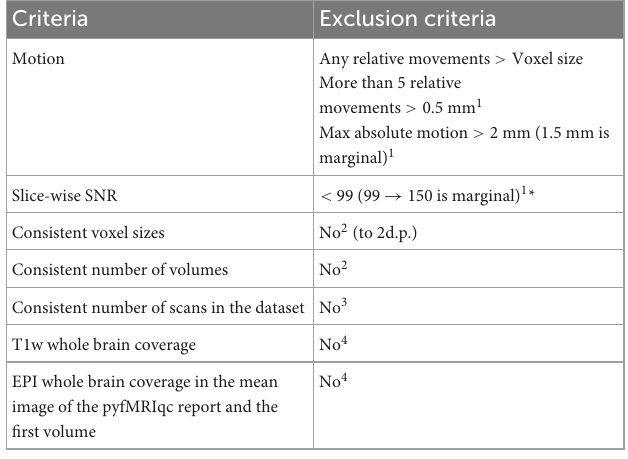
TABLE 2 Quantitative criteria for determining dataset